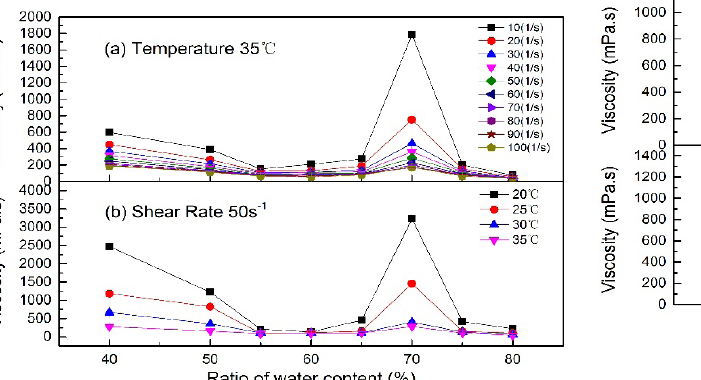
Figure 9: Dependencies of viscosity on the water content in the system of polymer concentration (920mg/L) and (a) temperature (35 ) (b) shear rate ℃